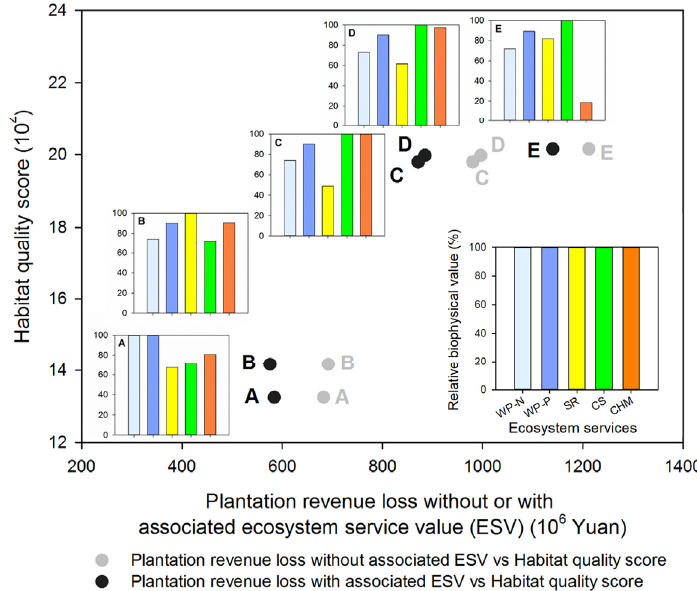
Figure 3. Relationship between habitat quality and plantation revenue loss (gray circles) or plantation revenue loss plus economic values of ecosystem services (dark circles). The potential ES values from forest restoration were the di ff erences in ES values between restored and baseline patterns (i.e., land-use pattern in 2017). WP-N, water purification (nitrogen reduction); WP-P, water purification (phosphorus reduction); SR, sediment reduction; CS, carbon sequestration; CHM, coastal hazard mitigation. A = minimum plantation revenue loss, B = 25% of maximum habitat quality value, C = 50% of maximum habitat quality value, D = 75% of maximum habitat quality value, and E = maximum value of habitat quality. Bar charts represent proportion of biophysical value relative to maximum value within each category of service.